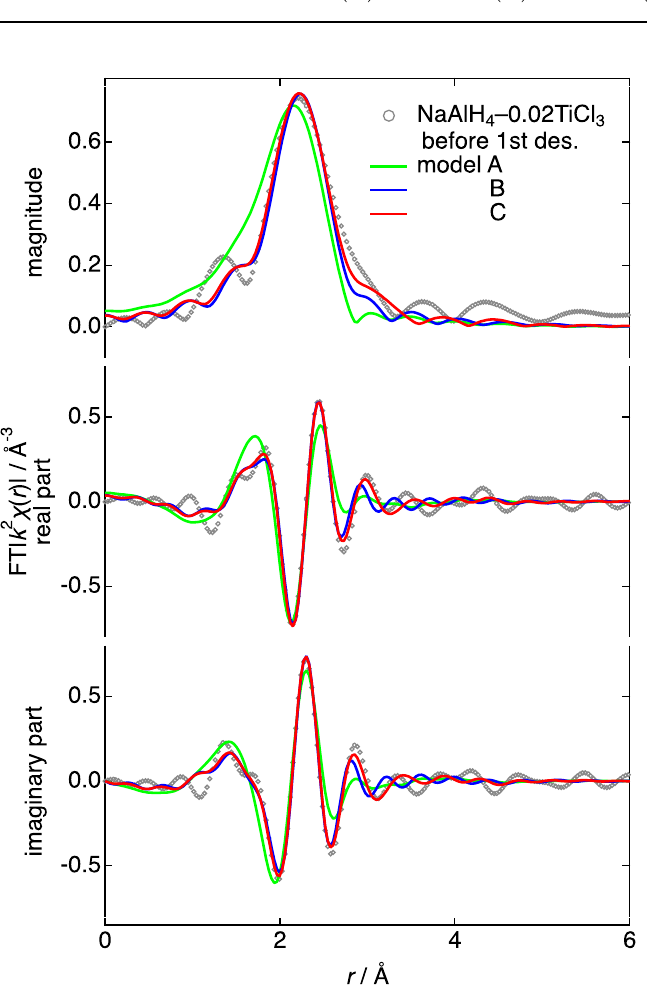
Figure 6. Fitting curves for radial distribution functions obtained from EXAFS spectra of NaAlH 4 – 0.02TiCl 3 before the hydrogen desorption.